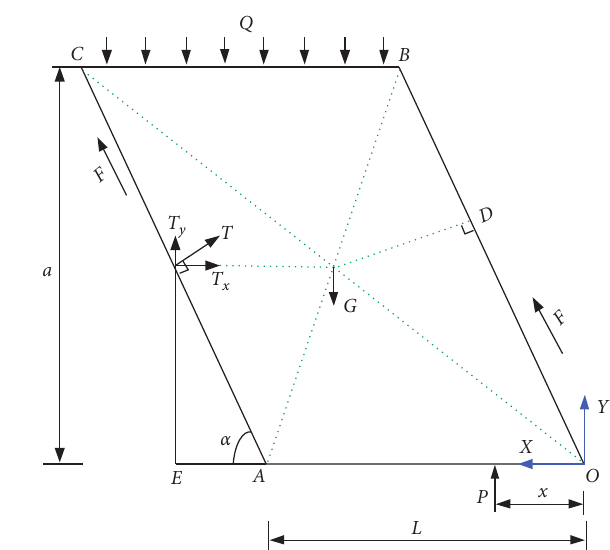
Figure 9: Stress analysis of cutting